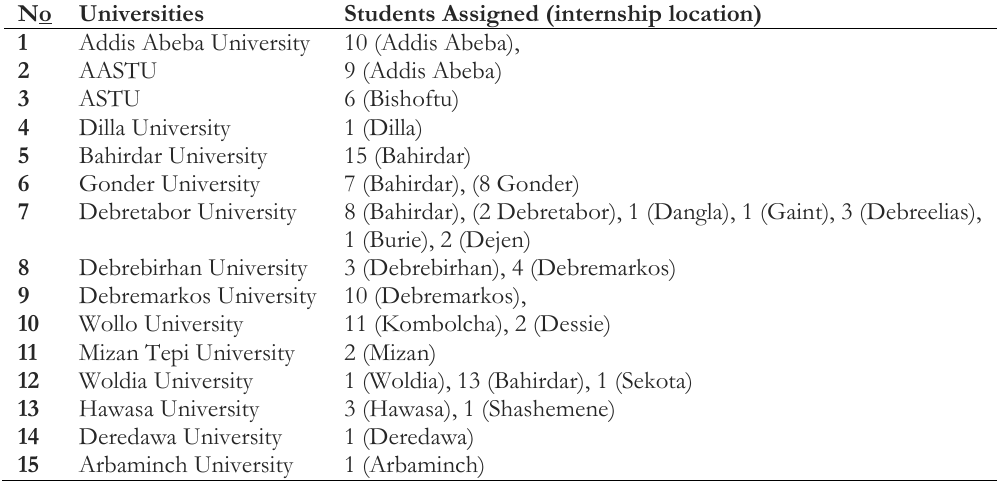
Table 2. Optimal assignment.